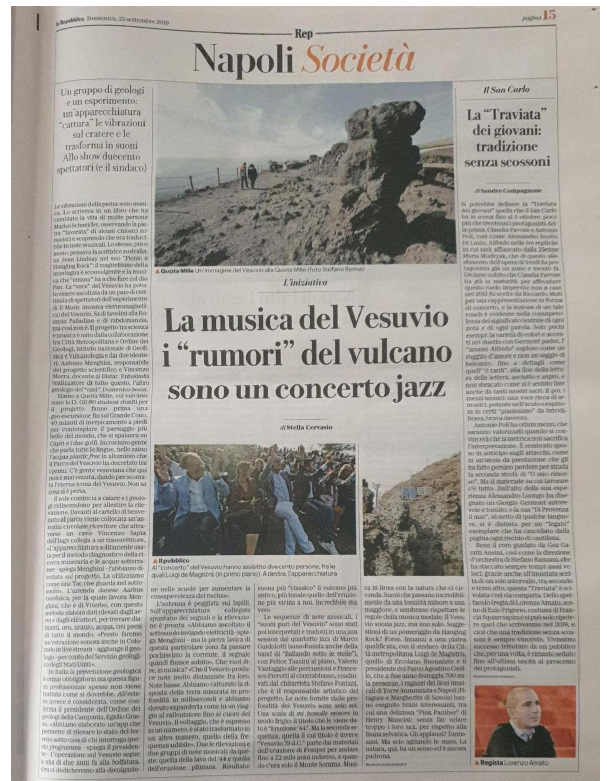
Figure 8. A full page of La Repubblica newspaper dedicated to the Vesuvius